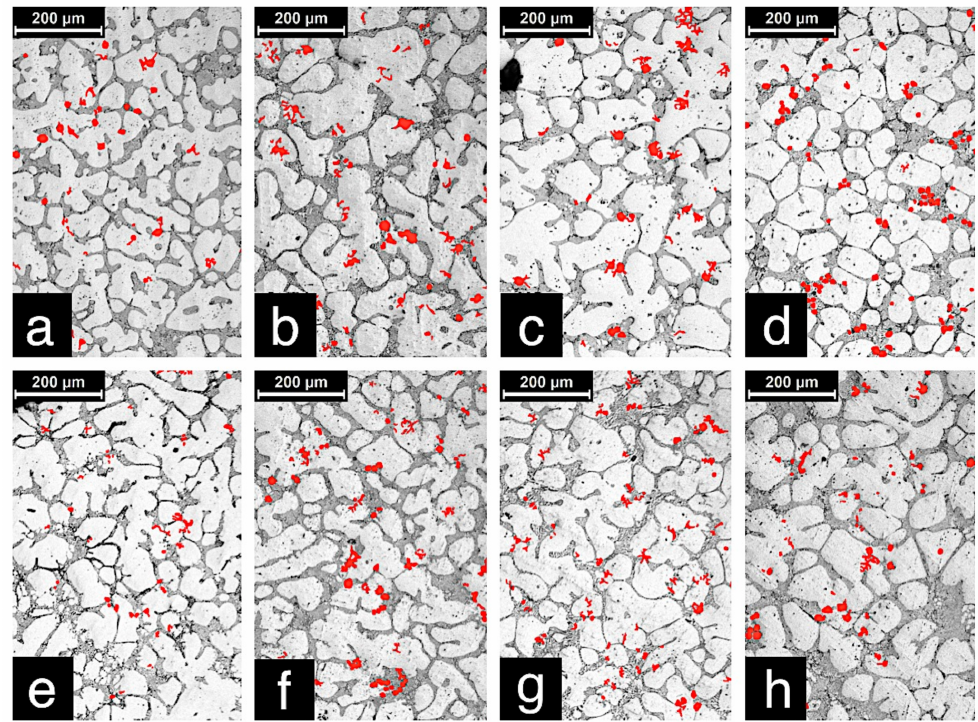
Figure 11. B&W micrographs showing globules in semisolid B319+Fe alloy after isothermal heat treatment at 591 ◦ C ( a – d ) and 595 ◦ C ( e – h ) for 0 s ( a , e ), 30 s ( b , f ), 60 s ( c , g ), and 90 s ( d , h ). Polyhedral α -Fe particles are highlighted in